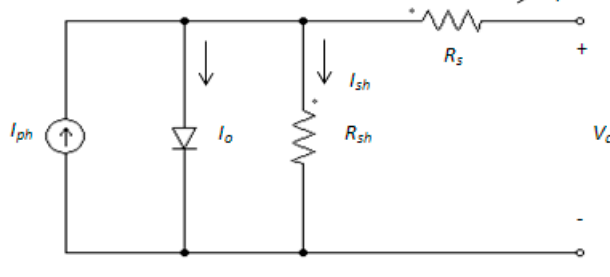
Figure 3. PV cell modeled as a diode circuit.